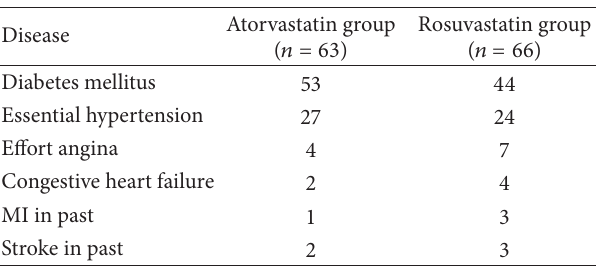
Table 2: Underlying